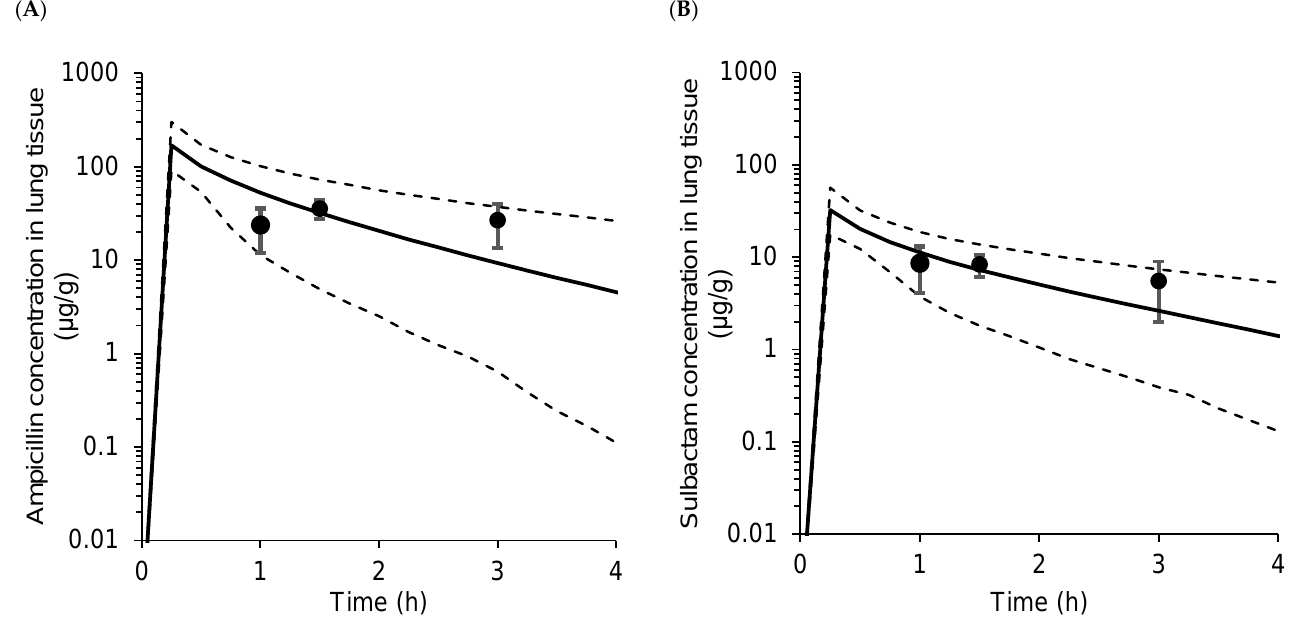
Figure 1. Visual predictive check plots of ( A ) ampicillin and ( B ) sulbactam, representing the ob- served lung tissue concentrations (mean ± standard deviation) after a 15-min of infusion of ampicil- lin/sulbactam 3 g (ampicillin 2 g and sulbactam 1 g) derived from the literature data [16]. The heavy line and dotted line denote the median and the 95% predicted interval, calculated from 1000 repli- cates, respectively.